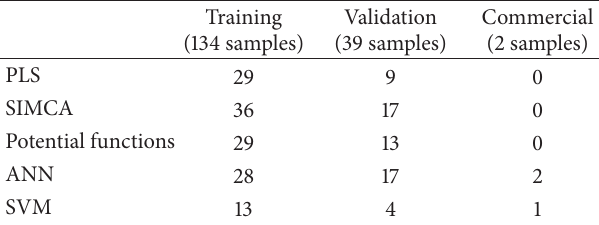
Table 9: Classification errors using variables selected by Procrustes rotation. Low concentration.